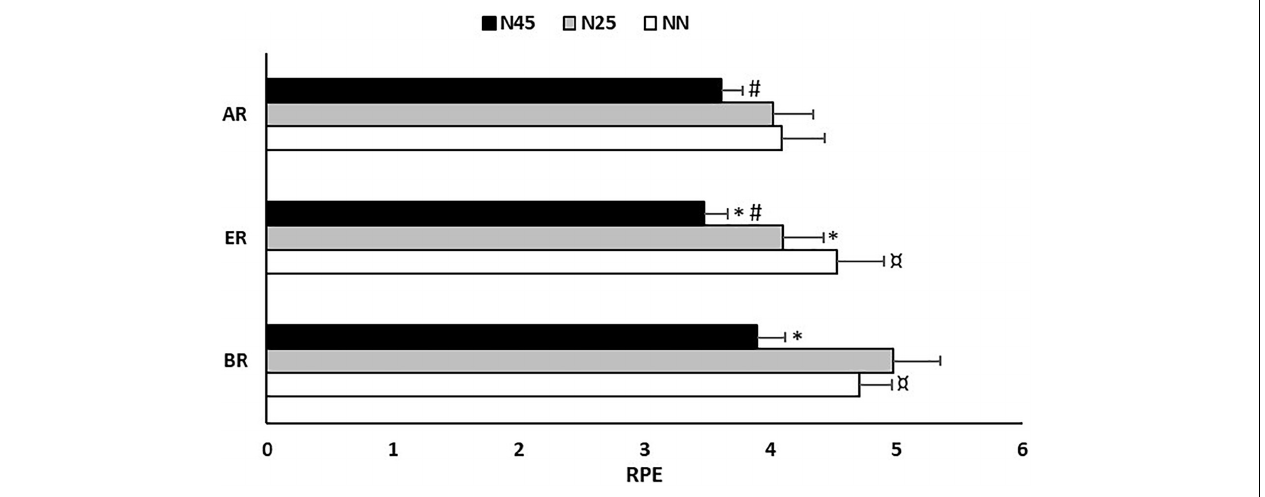
FIGURE 5 | Rating of perceived exertion (RPE) scores recorded during the 5-m shuttle run test in the no-nap condition (NN), the 25-min nap condition (N25), and the 45-min nap condition (N45), before (BR), during (ER), and after (AR) Ramadan. ∗ : Significant difference in comparison with NN; #: Significant difference in comparison with N25; $: Significant difference in comparison with